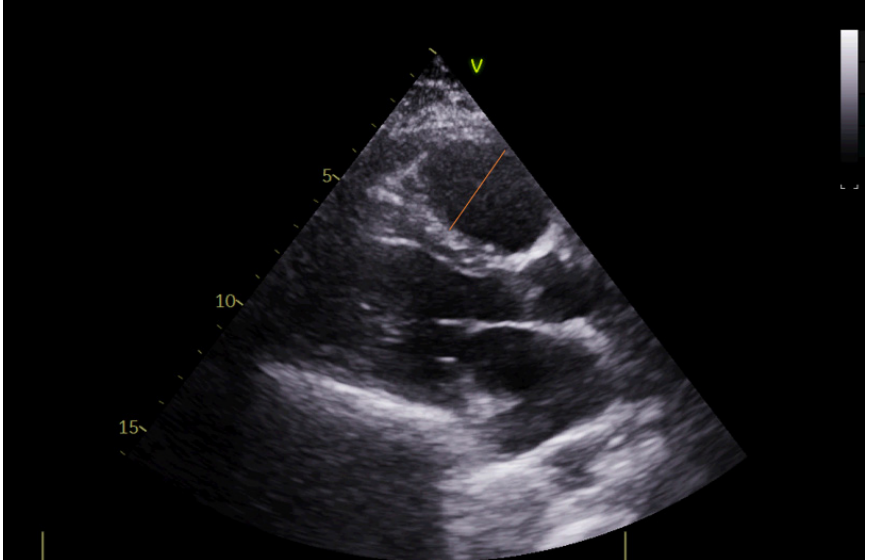
Diagnostics 2022 , 12 , x FOR PEER REVIEW Figure 2. Right ventricular diameter from the parasternal long-axis (PLAX) view.